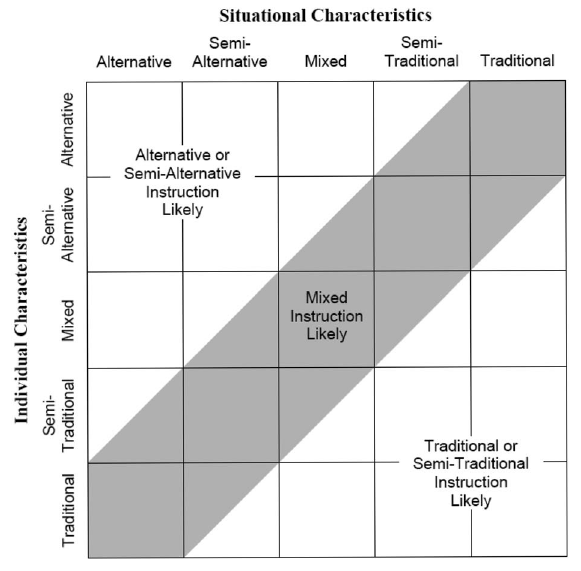
FIG. 1. Toy model for predicting behavior based on individual and situational